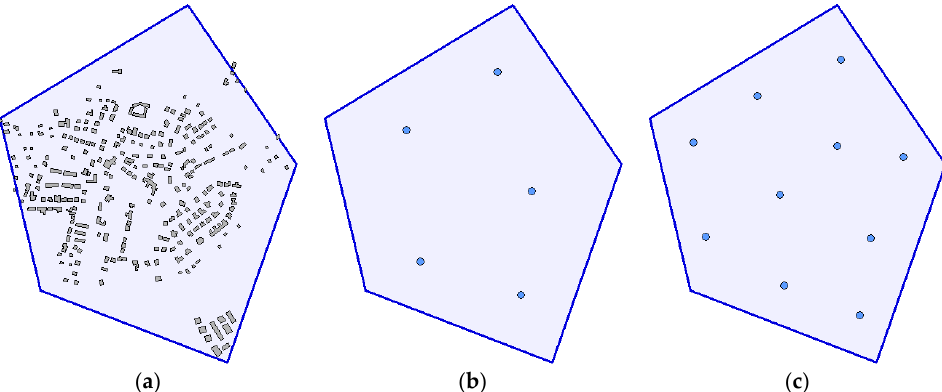
Figure 6. Scenario for the evaluation of a solution: ( a ) area of interest and the layout of obstacles; ( b ) deployment of waypoints for N = 5; ( c ) deployment of waypoints for N = 10.